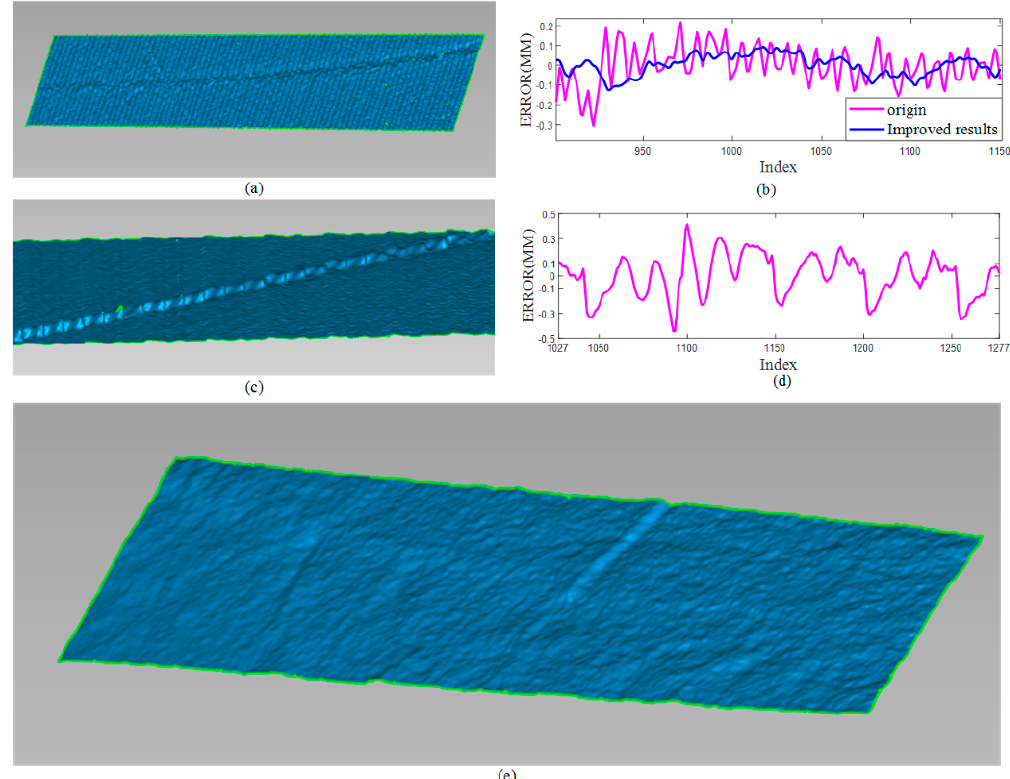
Figure 9. Results and comparison of metal plane. ( a ) The result by [2]; ( b ) The errors from the same row in camera image; ( c ) The result by phase-shifting method in [28]; ( d ) The errors from the same row by phase-shifting method in [28]; ( e ) The results by ours.